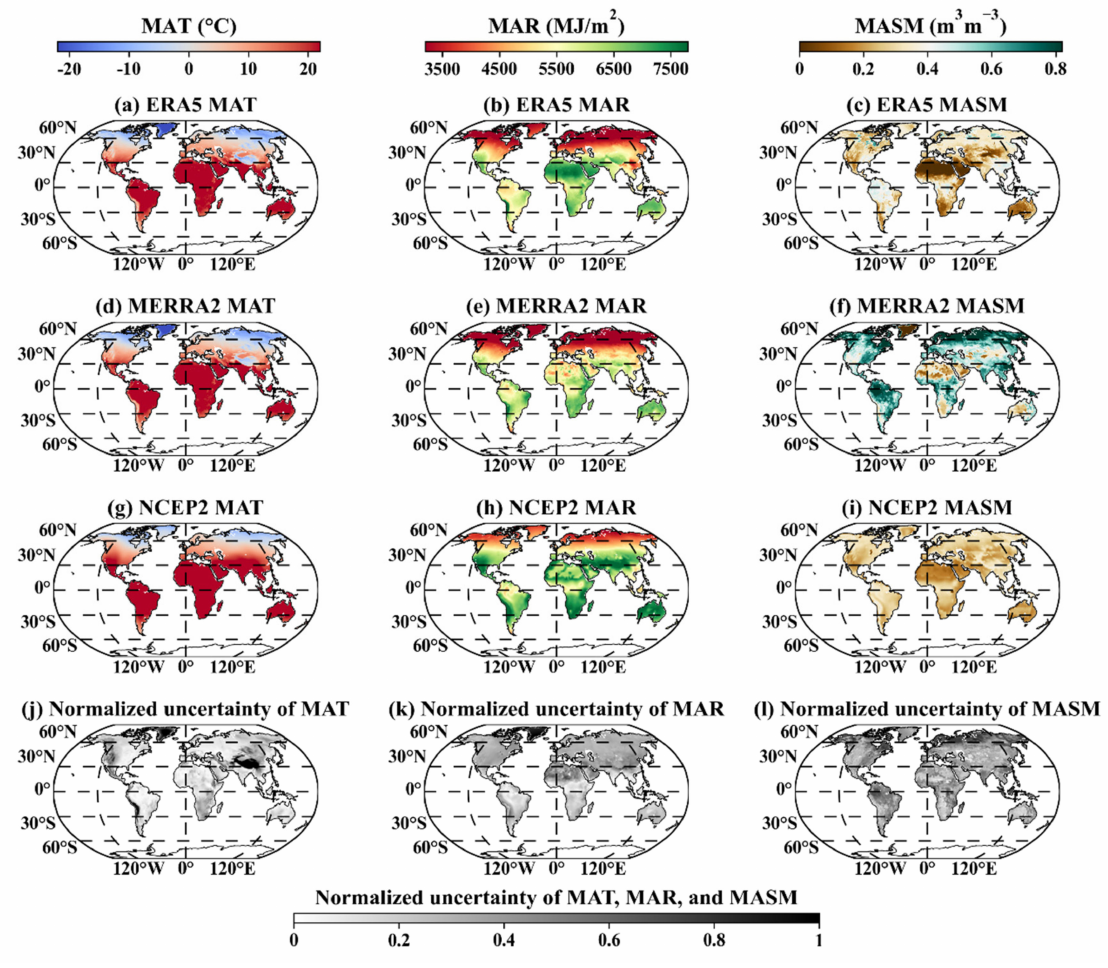
Figure 5. Spatial patterns of the MAT ( a , d , g ), MAR ( b , e , h ), MASM ( c , f , i ) (derived from ERA5, MERRA2, and NCEP2), and their spatial consistencies ( j , k , l ) from 2001 to 2020.